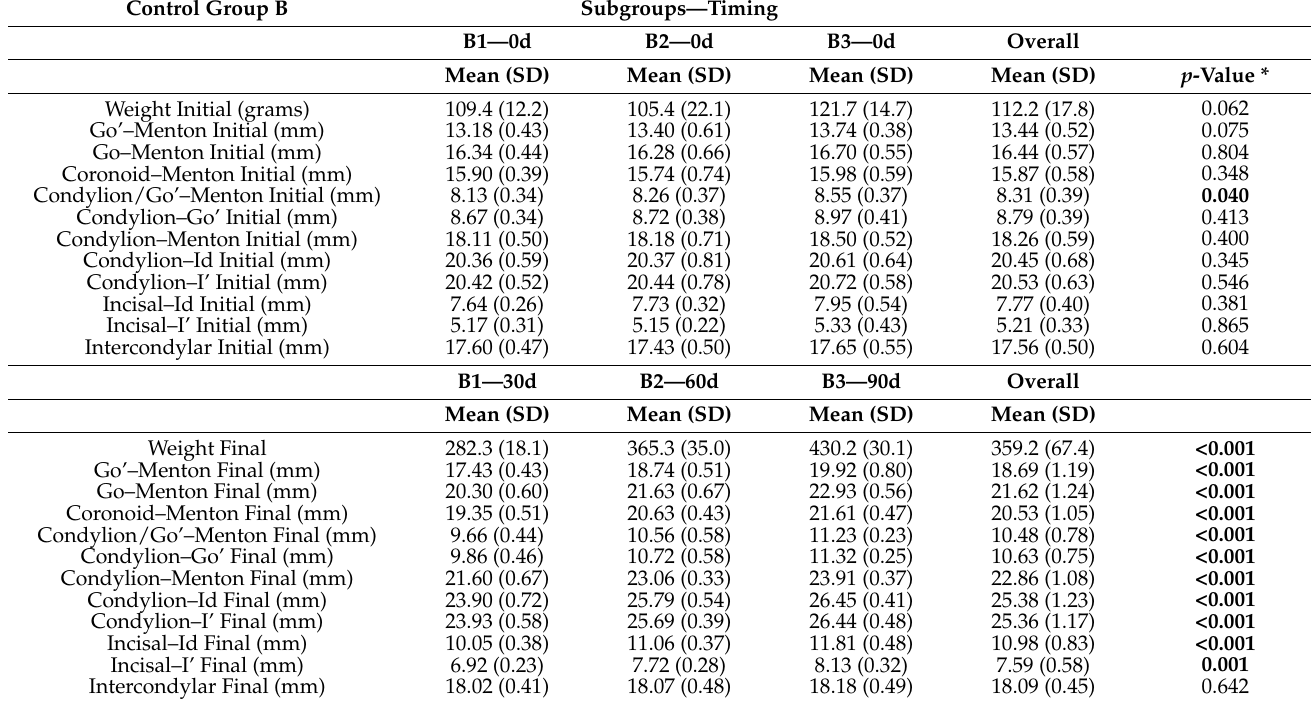
Table 3. Descriptive statistics (mean and standard deviation) for each measurement by subgroups and overall, for control group